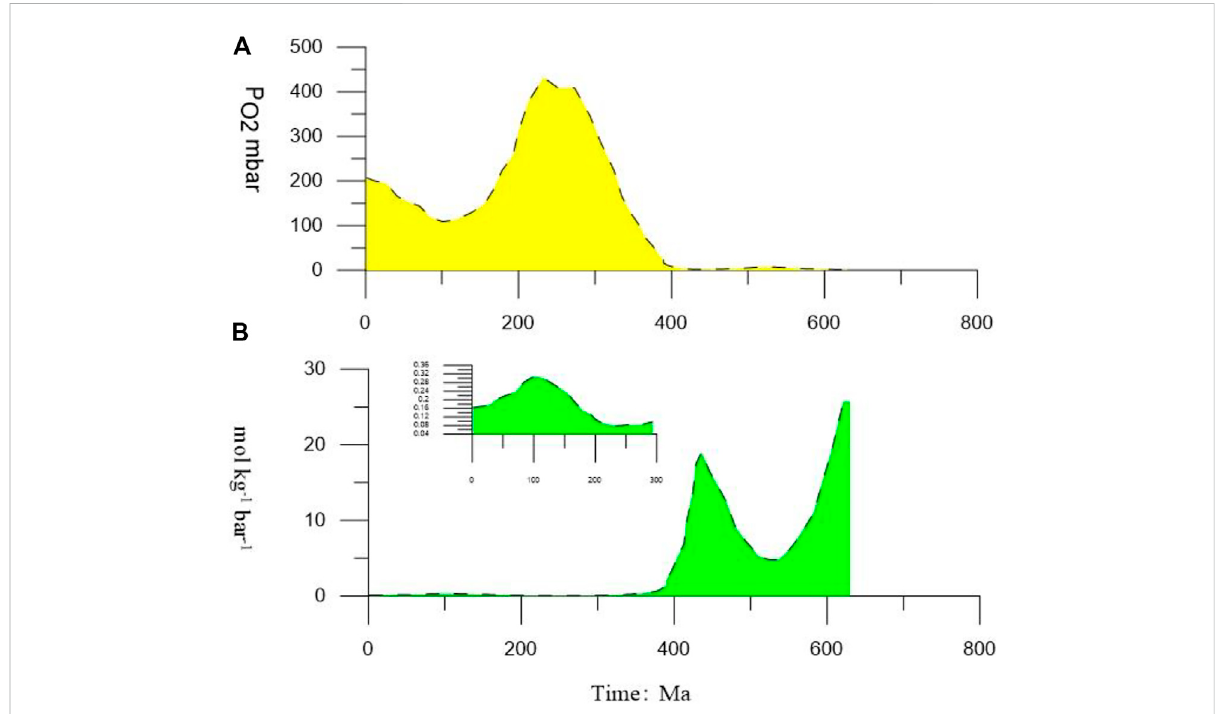
FIGURE 5 (A) Variation in thevalue of P O2 from presentto 600 Ma BP. (B) Critical values changes from present to 600 Ma BP underthe H 2 S released from thecompletedissociationofthe fi rstlayerofgashydrate.Moreover,fromthepresentto400